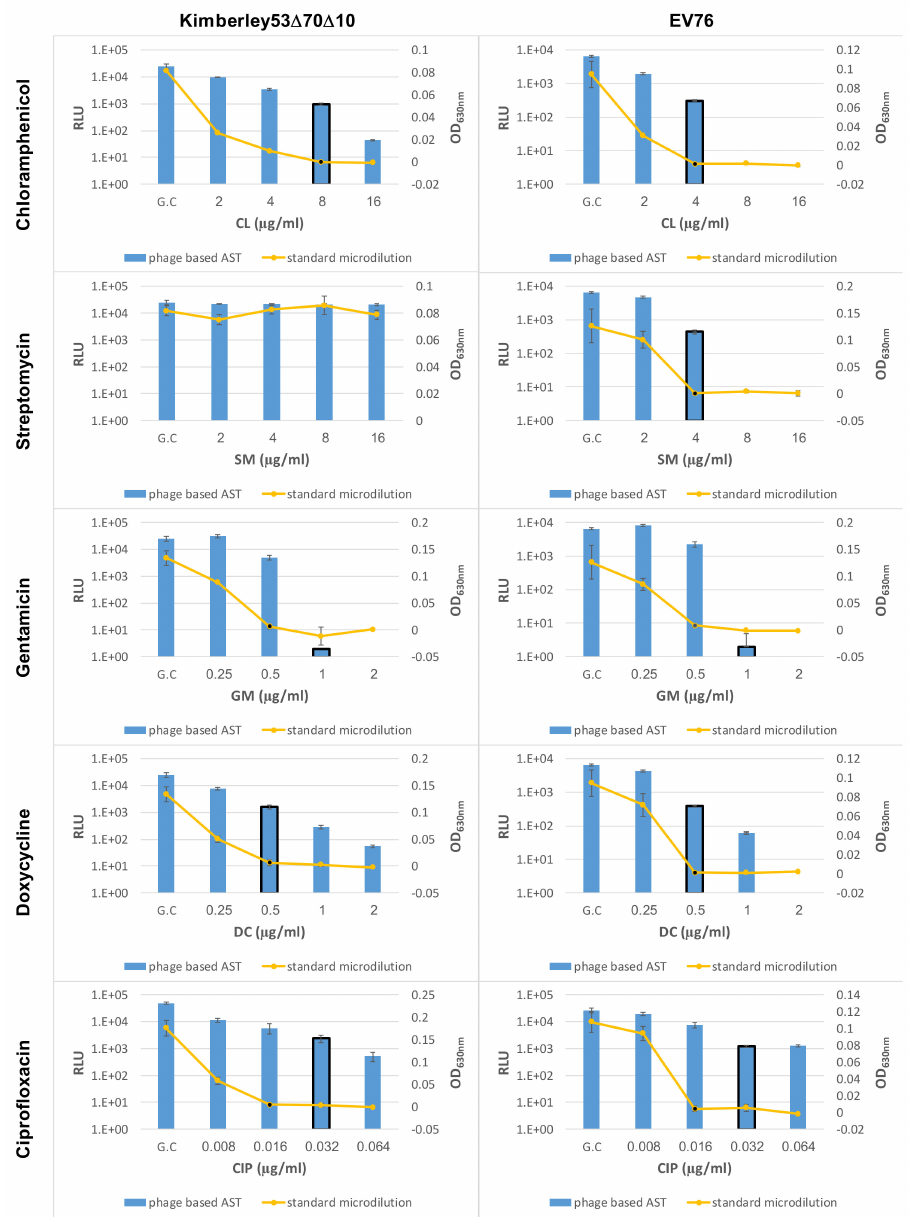
Figure 6. Direct phage-based AST of environmental samples spiked with Y. pestis . Y. pestis strains Kimberley53 ∆ 70 ∆ 10 or EV76 were inoculated into environmental asphalt samples prepared as described in the methods. Each inoculated culture was diluted 1:3 with MHB and tested by a phage-based bioluminescence ID assay, while the remaining sample was incubated at 28 ◦ C at 200 rpm for 1 h. After the evaluation of the bacterial concentration and dilution (if needed), the culture was tested by phage-based AST, with separate exposures to each of the five tested antibiotics, 7 h of exposure to CL, SM, GM and DC and 14 h of exposure to CIP. The resulting phage-based relative light units (RLUs, blue bars) are displayed in comparison to the OD 630 values resulting from the standard microdilution test of MHB-suspended homogenous cultures (yellow curves). The MIC values of the phage-based AST are marked by a black frame around the relevant bar, and the MIC values obtained in the standard test are marked by a black dot. Values are the mean of three triplicate wells in one experiment (error bars represent the standard deviation). The experiment was performed in two independent biological duplicates for both Y. pestis strains, and the figure shows one representative experiment. GC = Growth